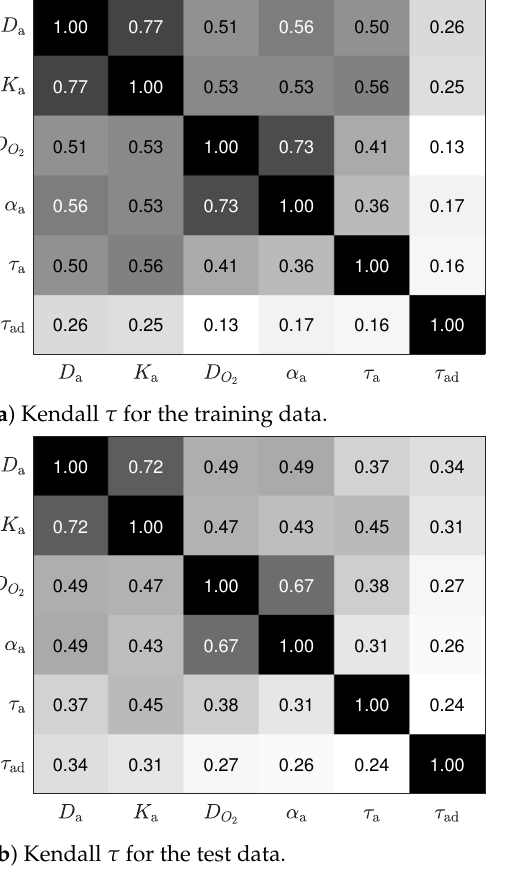
Figure 6. Kendall τ correlation coefficient for each pair of variables for the training and test